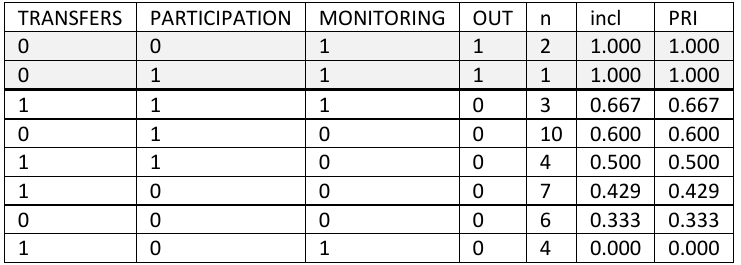
Table A2.10 Truth table for analysis of sufficiency for unsuccessful drought adaptation without